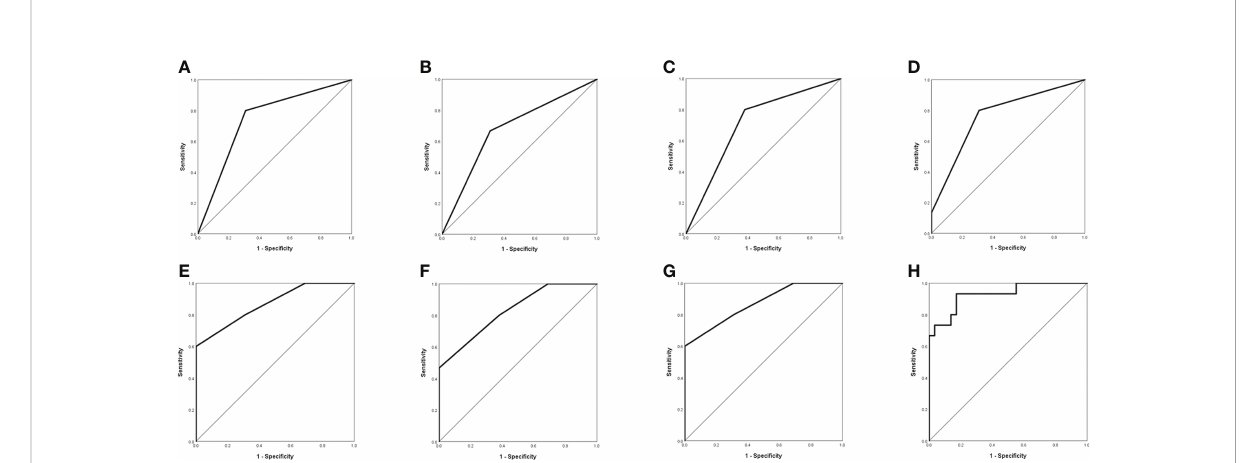
FIGURE 1 Evaluation of differential diagnosis ef fi cacy for MUT BRAF and WT BRAF in GBM. (A) : The AUC for quantity of ring was 0.745 (95% CI 0.590- 0.900); (B) : The AUC for quantity of located lobe was 0.678 (95% CI 0.508-0.849); (C) : The AUC for shape of ring was 0.710 (95% CI 0.550- 0.871); (D) : The AUC for quantity of ring + quantity of located lobe was 0.766 (95% CI 0.613-0.918); (E) : The AUC for quantity of ring + shape of ring was 0.869 (95% CI 0.753-0.985); (F) : The AUC for quantity of located lobe + shape of ring was 0.830 (95% CI 0.702-0.957); (G) : The AUC for quantity of ring + quantity of located lobe + shape of ring was 0.869 (95% CI 0.753-0.985); (H) : The AUC for quantity of ring + quantity of located lobe + shape of ring + thickness of ring +maximal diameter of ring was 0.929 (95% CI